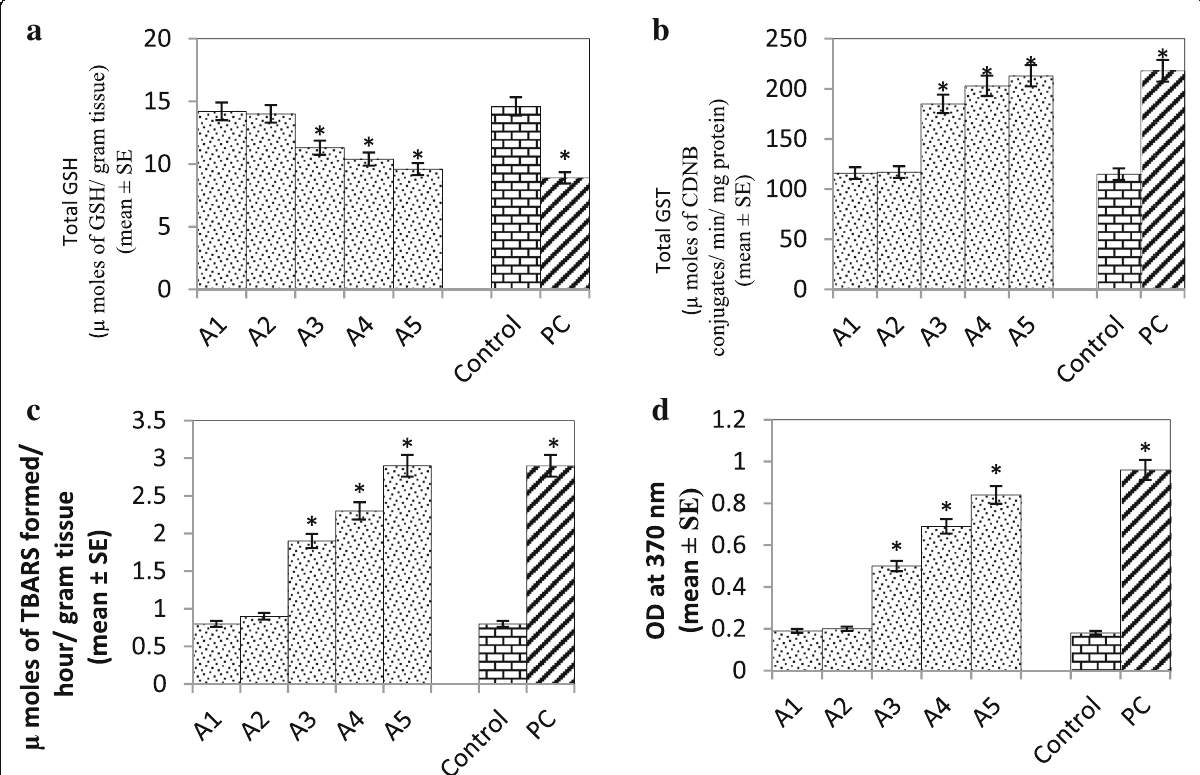
Fig. 2 Glutathione content ( a ), glutathione-S-transferase activity ( b ), lipid peroxidation ( c ) and protein carbonyl content ( d ) in the brain of flies exposed to various doses of arecoline (A1 = 5 μ M arecoline, A2 = 10 μ M arecoline, A3 = 20 μ M arecoline, A4 = 40 μ M arecoline, A5 = 80 μ M arecoline, PC = 10 μ l/ml methyl methanesulphonate), * significant at p < 0.05 compared to